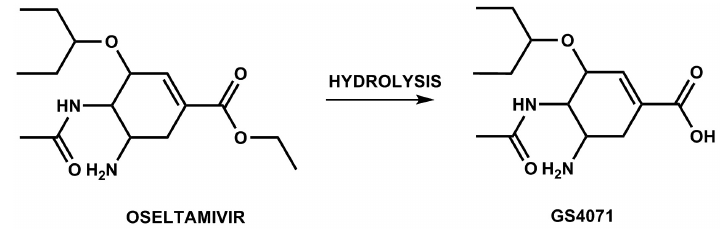
FIGURE 18 - The activation of olsetamivir into the active metabolite